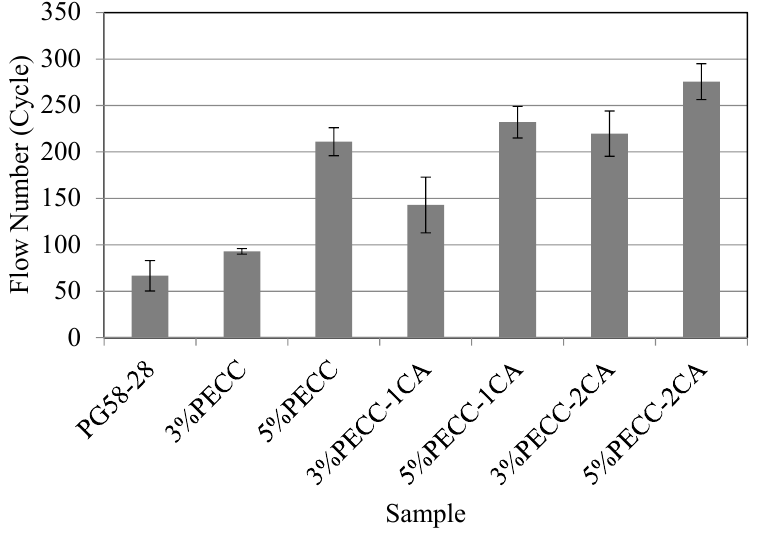
Figure 11. Flow number test results.